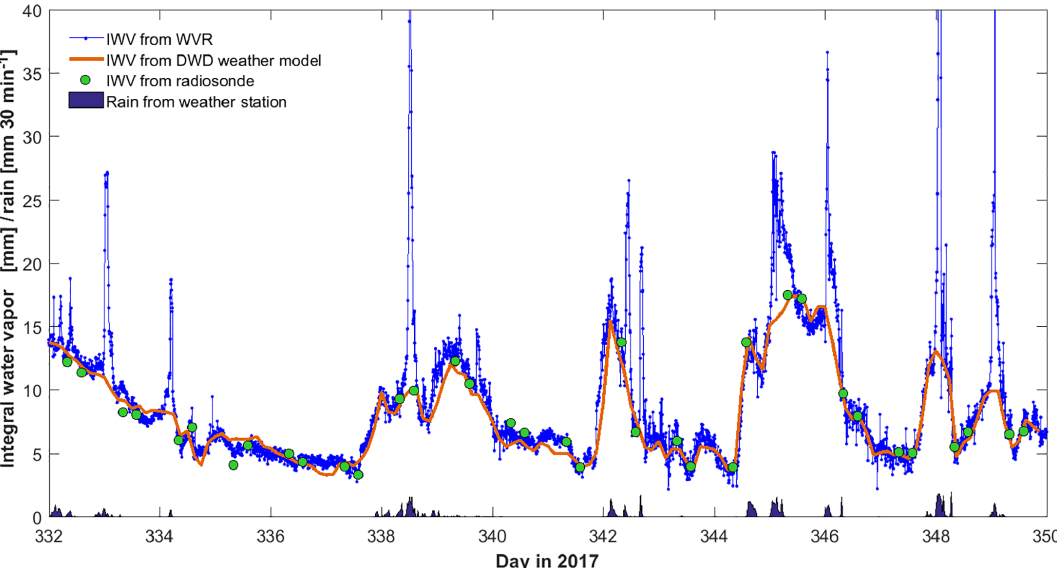
Figure 7. Integrated water vapor (IWV) content as measured by the water vapor radiometer (WVR) compared to IWV values derived from weather model and radiosonde data. WVR spikes coincide with periods of rain.